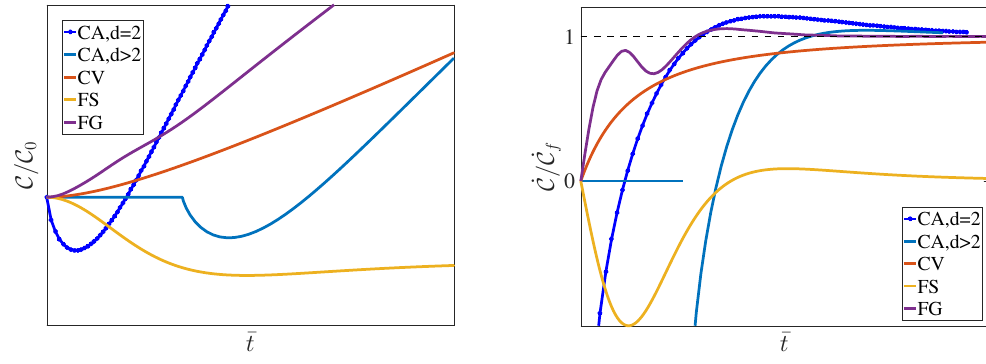
Figure 9 . Schematic plots for the complexity by four methods: the holographic CV and CA conjecture and the (cid:12)eld theoretic FS and FG methods. It is obtained from (cid:12)gures 2, 3, 5, 7, and 8. (cid:22) t = t L + t R . Left: C = C 0 , where C 0 is the complexity at rate at (cid:22) t ! 1 in CA,CV and FG methods, and _ C f = (cid:0) _ C min in the FS